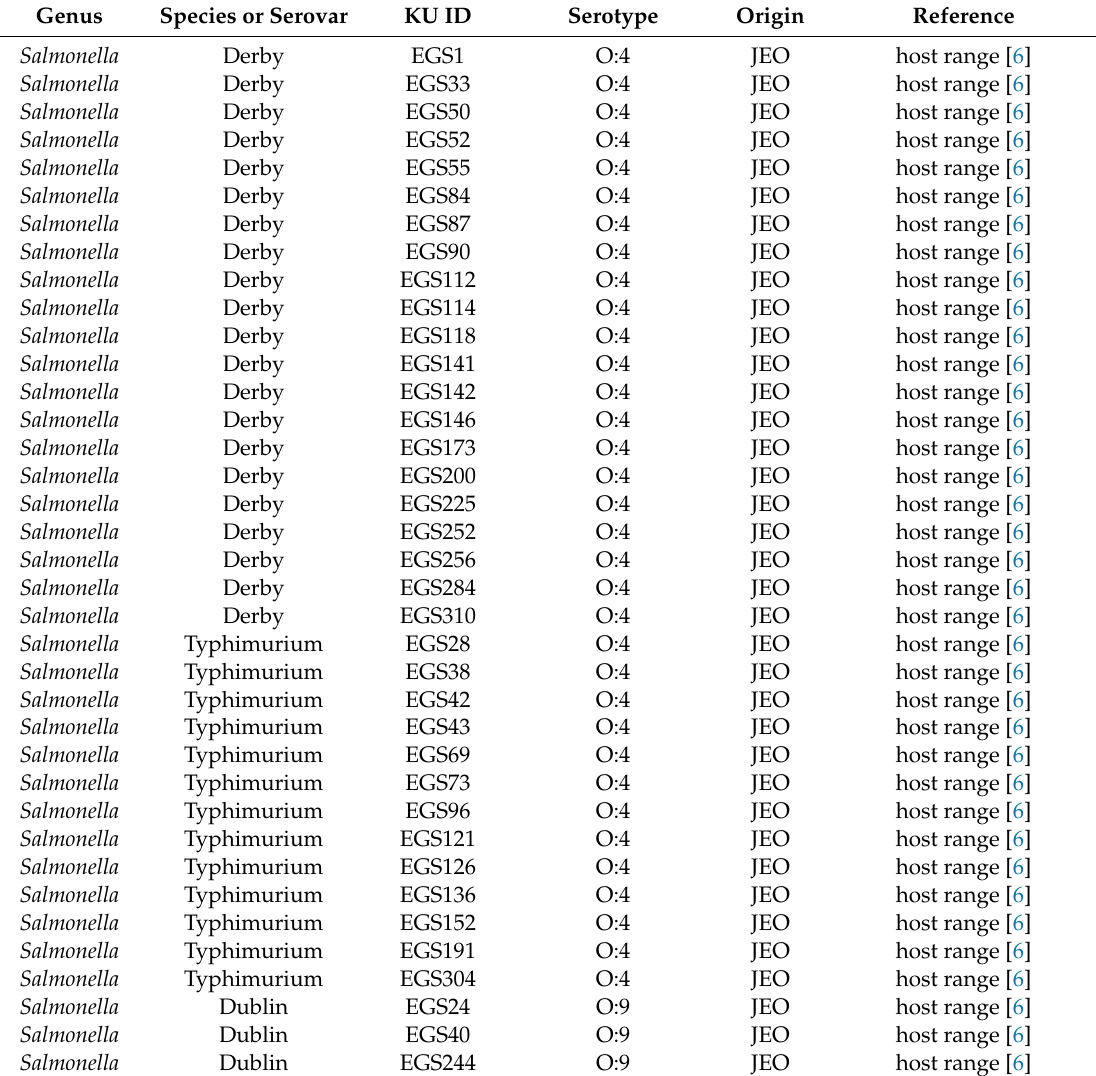
Table A1. Strains used for isolation, propagation and host range analyses of phage S144. Genus, species, internal code for identification, serotype (ND, not determined), collection of origin (JEO, John Emerald Olsen) and its use in this manuscript or in [6] have been indicated. Genus Species or Serovar KU ID